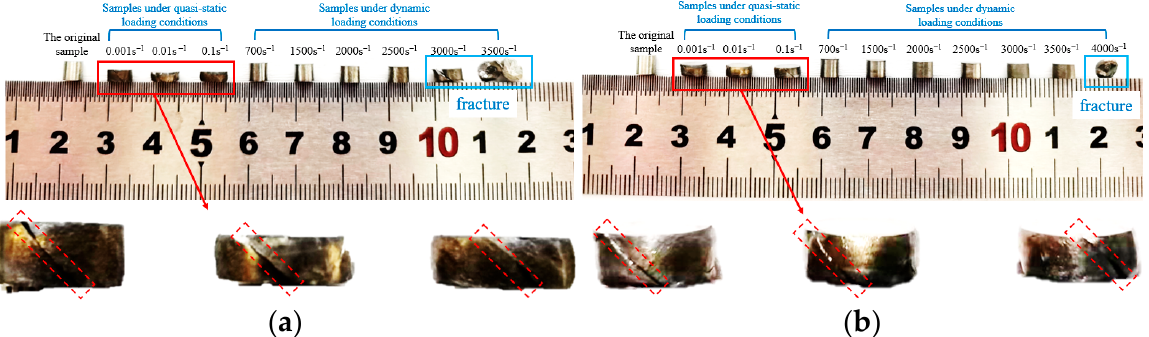
Figure 6. Macro-morphology of uniaxially compressed specimens after compression. ( a ) Group Z specimens (deposition direction). ( b ) Group X specimens (scanning direction).